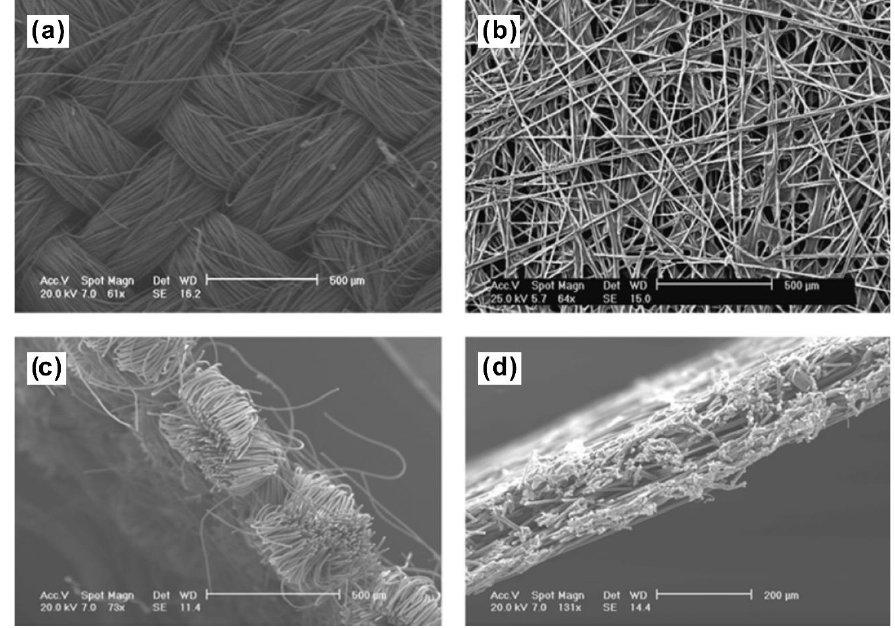
Figure 3. SEM images of the configurations of fibers in ( a , c ) carbon fiber cloth (Ballard 1071HCB), and ( b , d ) carbon fiber paper (Toray H-060) [46].